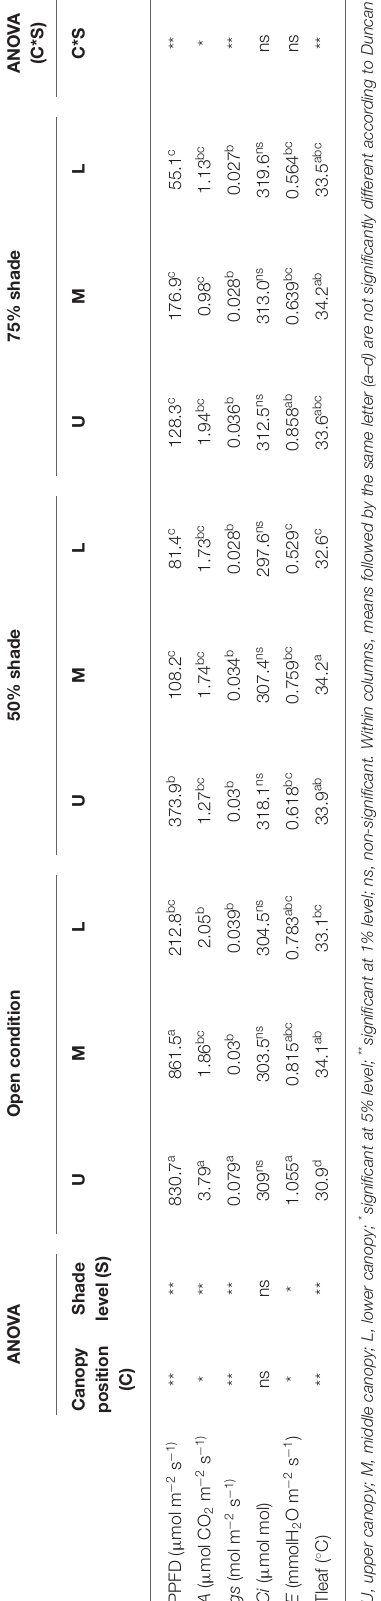
TABLE 5 | The effects of light intensity on microclimate changes near